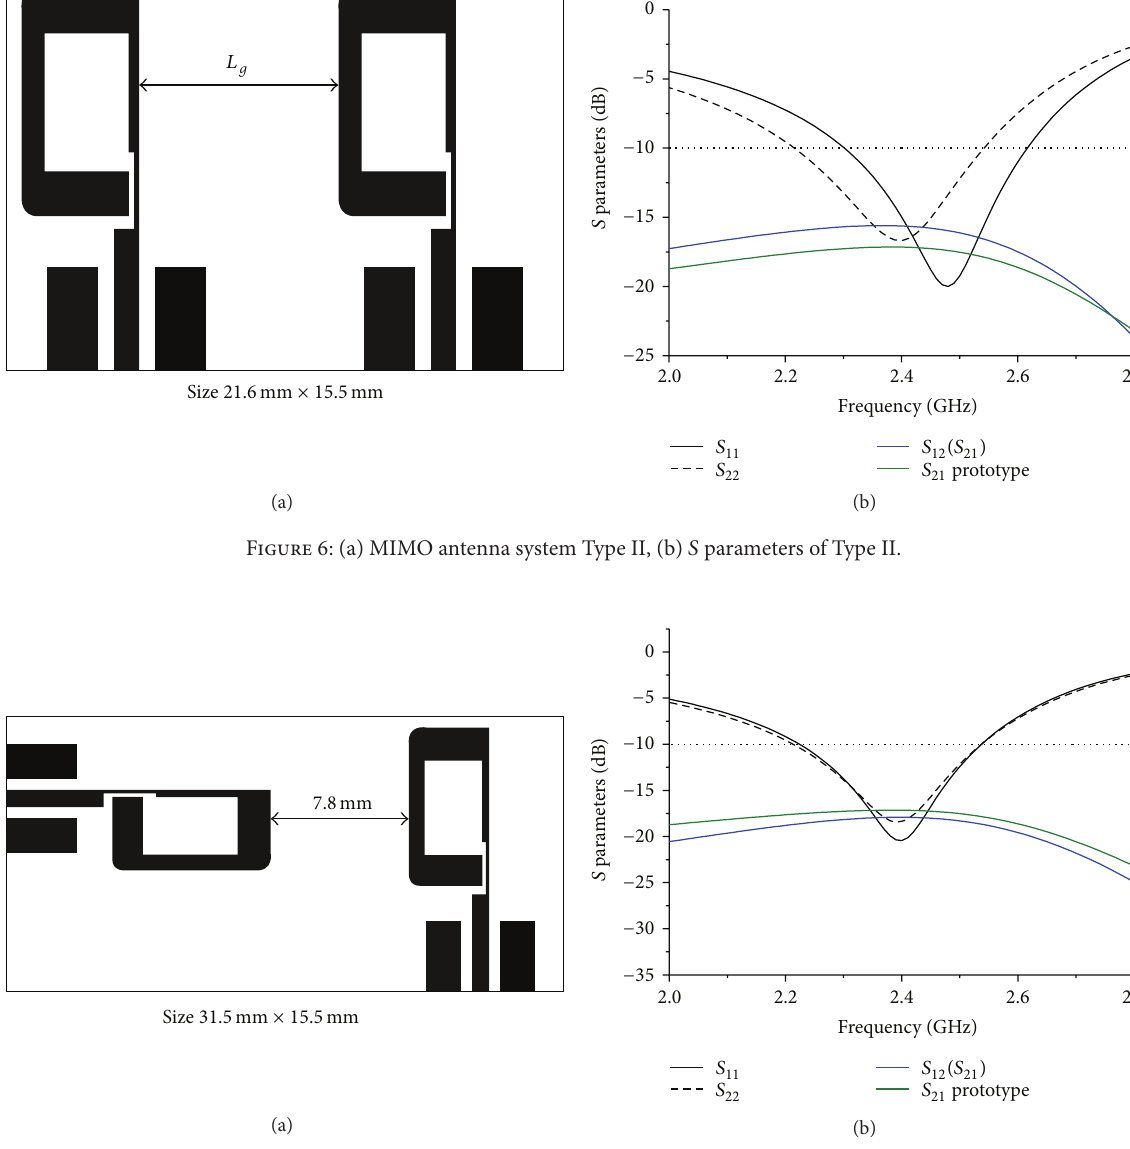
Figure 7: (a) Orthogonally arranged MIMO antenna system, (b) 𝑆